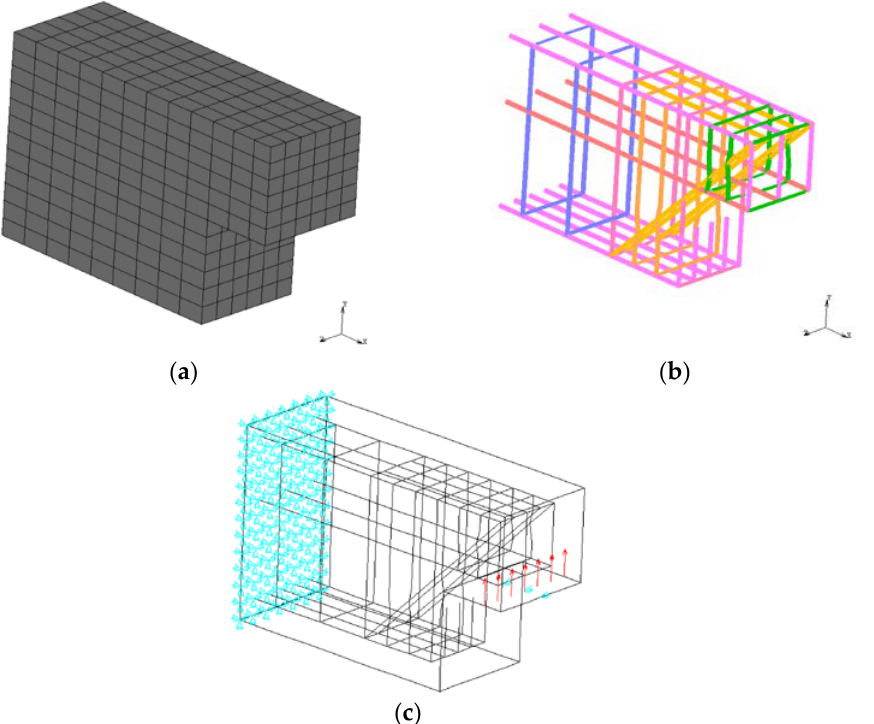
Figure 13. ( a ) SOLID65 concrete matrix mesh; ( b ) TRUSS180 steel reinforcement; ( c ) boundary conditions.